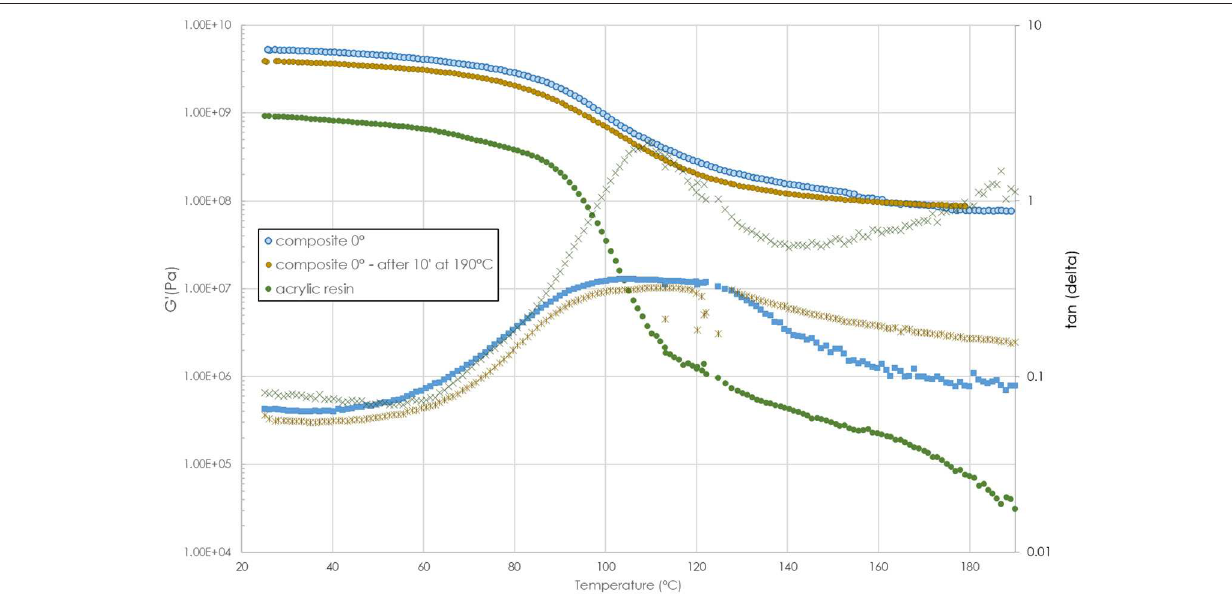
Frontiers in Materials |